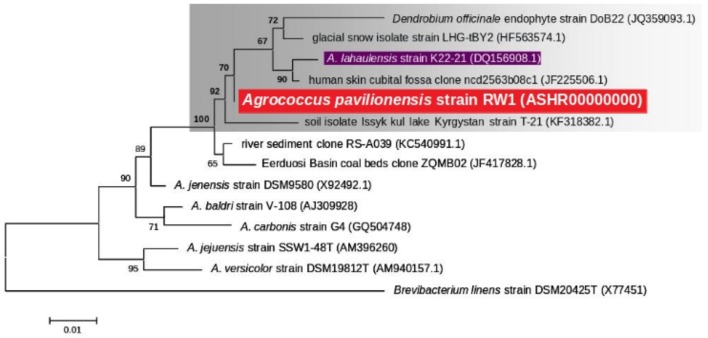
Maximum likelihood tree based on 16S rRNA gene sequences (∼1409 bp) showing the phylogenetic relationship among the different isolates of the genus Agrococcus. Bootstrap values greater than 50% are given at nodes. Bar represents a nucleotide substitution rate per 100 nucleotides.